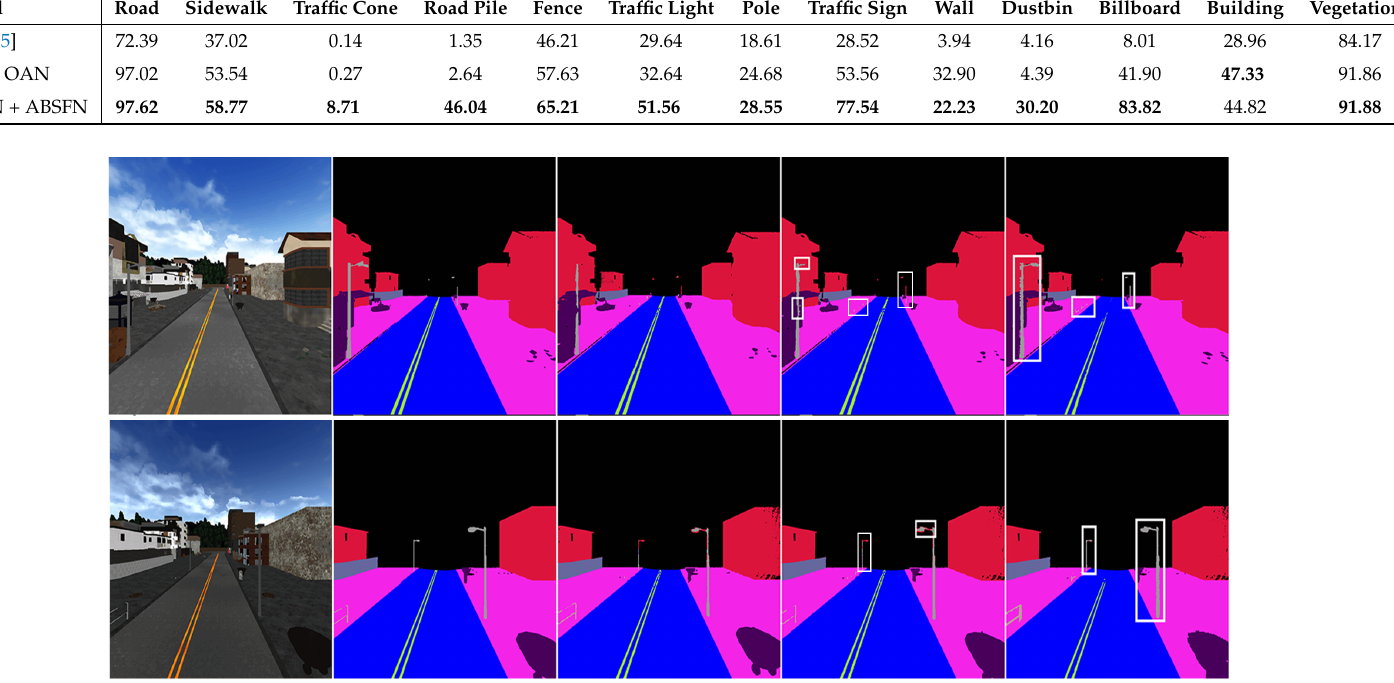
Figure 9. Visualization of CARLA dataset. From the left, RGB images, ground truth, ICNET [15], ICNET [15] +OAN, ICNET [15] + OAN + ABSFN. Different colors represent different